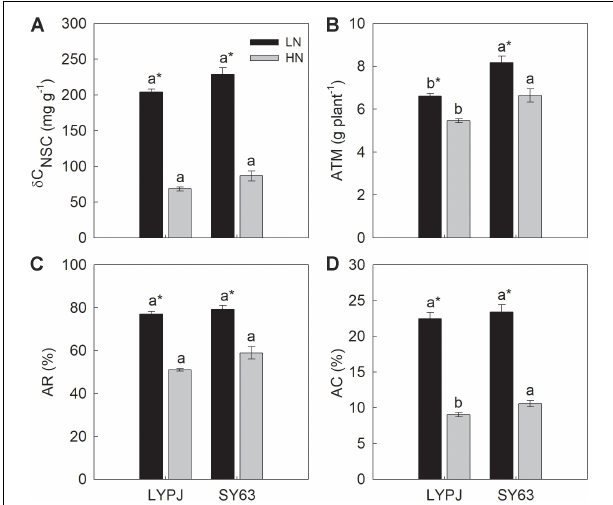
FIGURE 4 | The difference of stem NSC concentrations between heading and at maturity ( δ C NSC ) (A) , apparent transferred mass of NSC (ATM) (B) , apparent ratio of transferred NSC (AR) (C) , and apparent contribution of transferred NSC to grain yield (AC) (D) in LYPJ and SY63 cultivars under LN and HN treatments. Vertical bars represent mean ± standard error ( n = 3). Different letters on top of histograms indicate significant differences at P < 0.05 between the two varieties under the same nitrogen condition. ∗ Indicates significance at P < 0.05 between LN and HN for the same